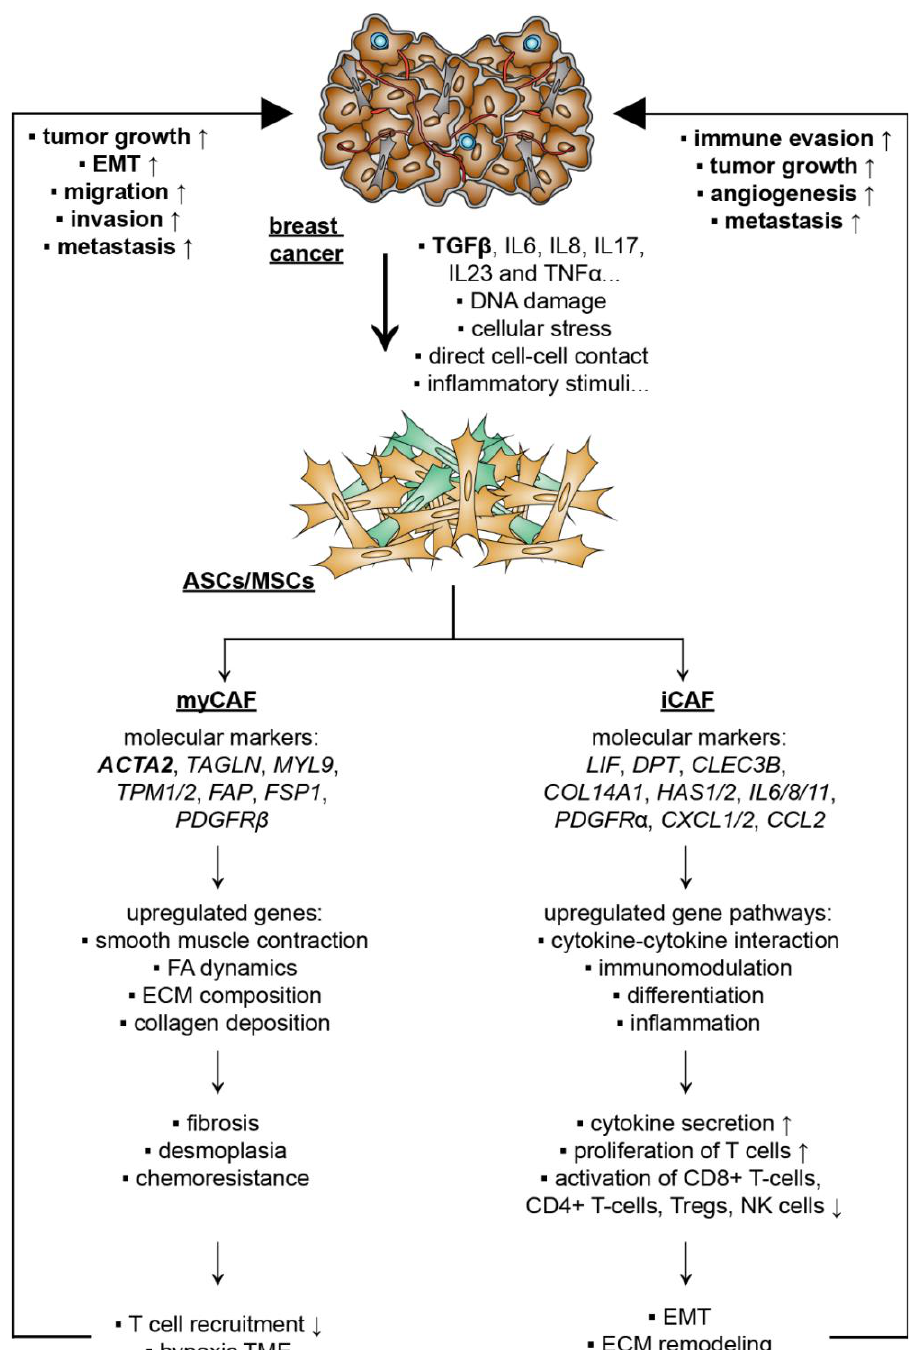
Figure 3. Simplified model showing that breast cancer cells induce de-differentiation of MSCs/ASCs into at least two distinct CAF subtypes. The de-differentiation process of MSCs/ASCs in the TME of breast cancer is triggered by multiple factors including cytokines TGF β , IL6, IL8, IL17, IL23, and TNF α , DNA damage, cellular stress, direct cell–cell contact and inflammatory stimuli. This malignant transformation shifts ASCs/MSCs into several cancer-supportive populations including two typical phenotypes: myCAFs promoting tumor growth, EMT, migration, invasion, and metastasis, and iCAFs mediating immune evasion, tumor growth, angiogenesis, and metastasis. ASCs, adipose tissue-derived mesenchymal stromal/stem cells; MSCs, mesenchymal stromal/stem cells; TGF β , transforming growth factor β ; IL6, interleukin 6; EMT, epithelial-to-mesenchymal transition; TNF α , tumor necrosis factor α; ECM, extracellular matr ix; TME, tumor microenvironment; CD8, cluster of differentiation 8; myCAF, myofibroblast cancer-associated fibroblast; iCAF, inflammatory cancer- associated fibroblast; ACTA2, smooth muscle actin, TAGLN, transgelin; MYL9, myosin light chain 9; TPM, tropomyosin; FAP, fibroblast activation protein; FSP1, fibroblast-specific protein-1; PDG- FRβ, platelet -derived growth factor receptor beta; LIF, leukemia inhibitory factor; CXCL, chemo- kines C-X-C ligand; HAS, hyaluronan synthase; CCL, monocyte chemotactic and activating factor; COL14A1, collagen type XIV alpha 1 chain.